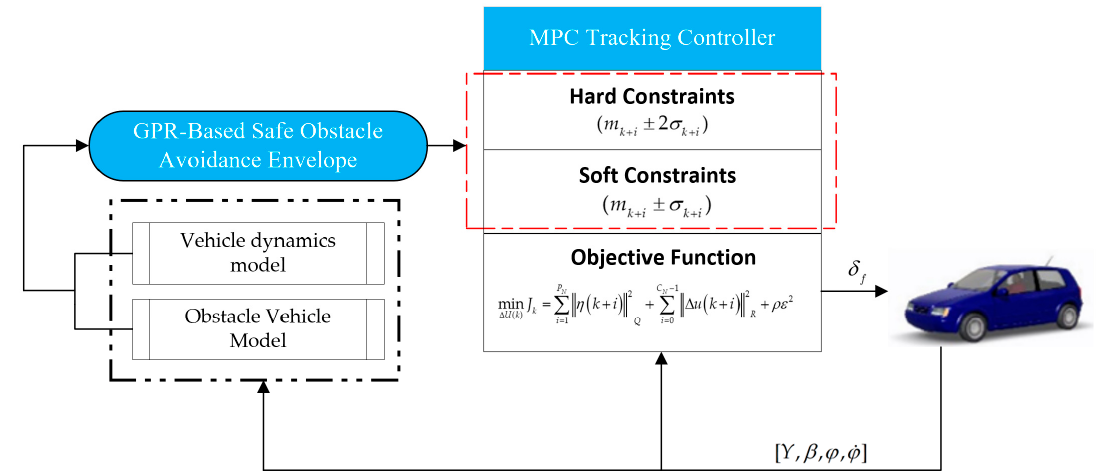
Figure 1. The framework of the proposed obstacle avoidance controller.